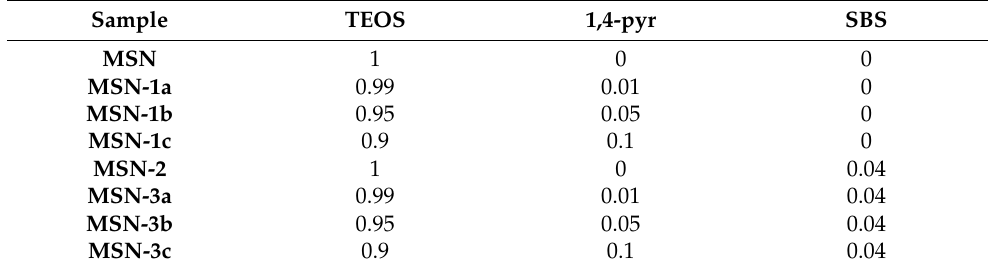
Table 1. Proportional molar amounts of the different reactants added to the